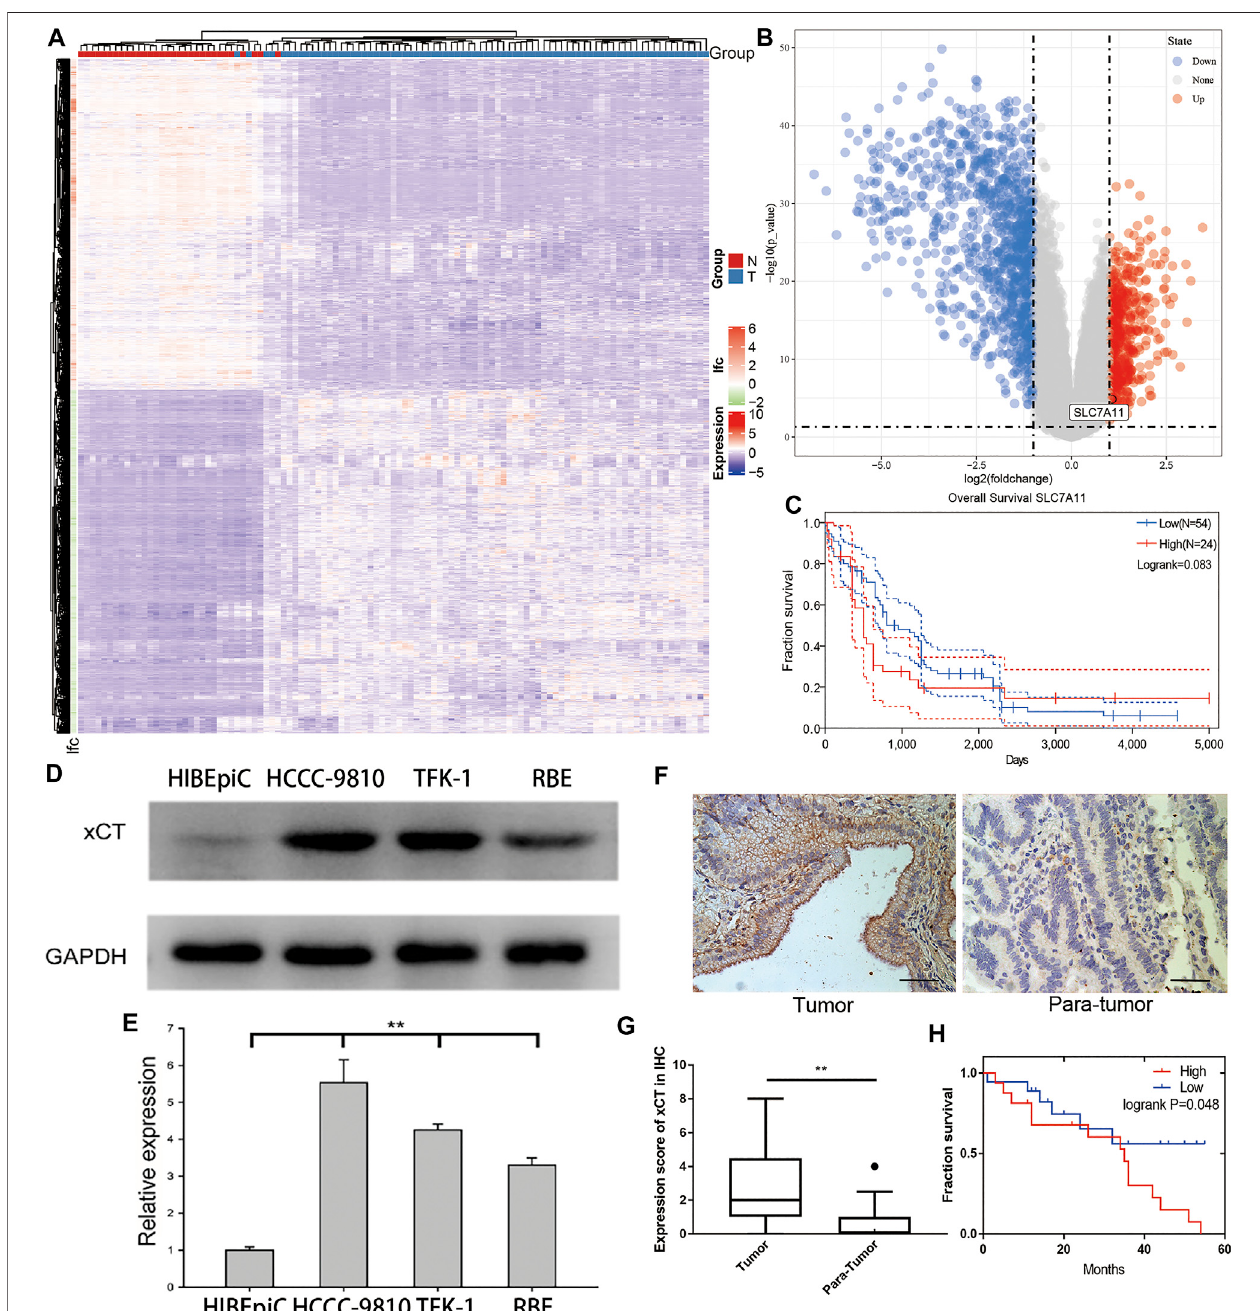
FIGURE1| TheexpressionofxCTincholangiocarcinomaanditsrelationshipwiththeprognosisofpatients. (A,B) Differentialgeneheatmapandvolcanomapfrom the E-MTAB-6389 dataset which include 78 tumour (T group) and 31 adjacent tissue (N group) samples with high and low expression; xCT ( SLC7A11 ) is marked. (C) Survival analysis of xCT in the E-MTAB-6389 dataset. (D,E) xCT expression levels and histograms in normal bile duct epithelium HIBEpiC cells and cholangiocarcinoma HCCC-9810, TFK-1 and RBE cells. (F,G) The represent images and histogram of xCT in cholangiocarcinoma tumour and adjacent tissues (34 pairs). (H) Survival analysis showed the effect of different expression levels of xCT on the survival time of patients with cholangiocarcinoma (High, high expression group; Low, low expression group).